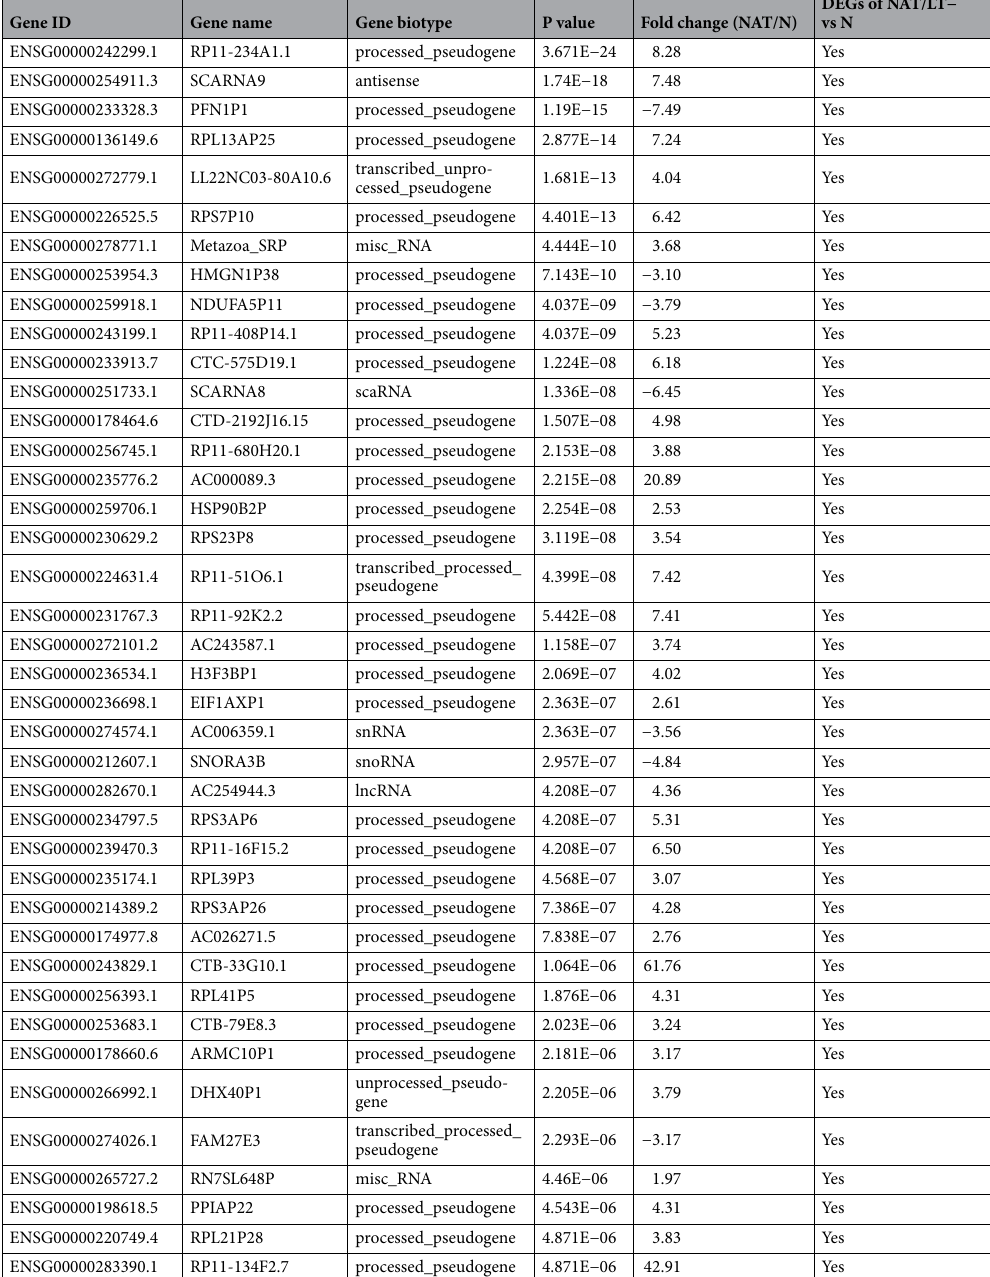
Table 2. Top 40 differentially expressed non-coding genes between NAT and N. The abbreviations, gene annotation, and statistics are the same as described in Table